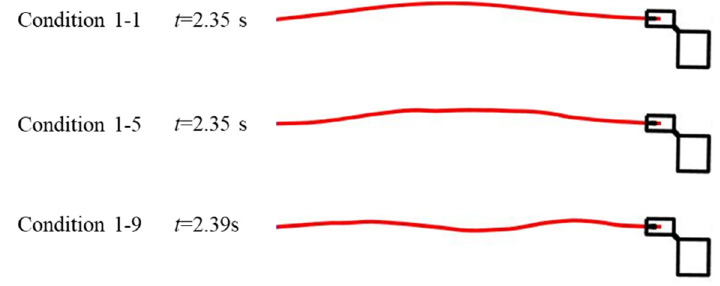
Figure 14. Shape of system during tether extension.